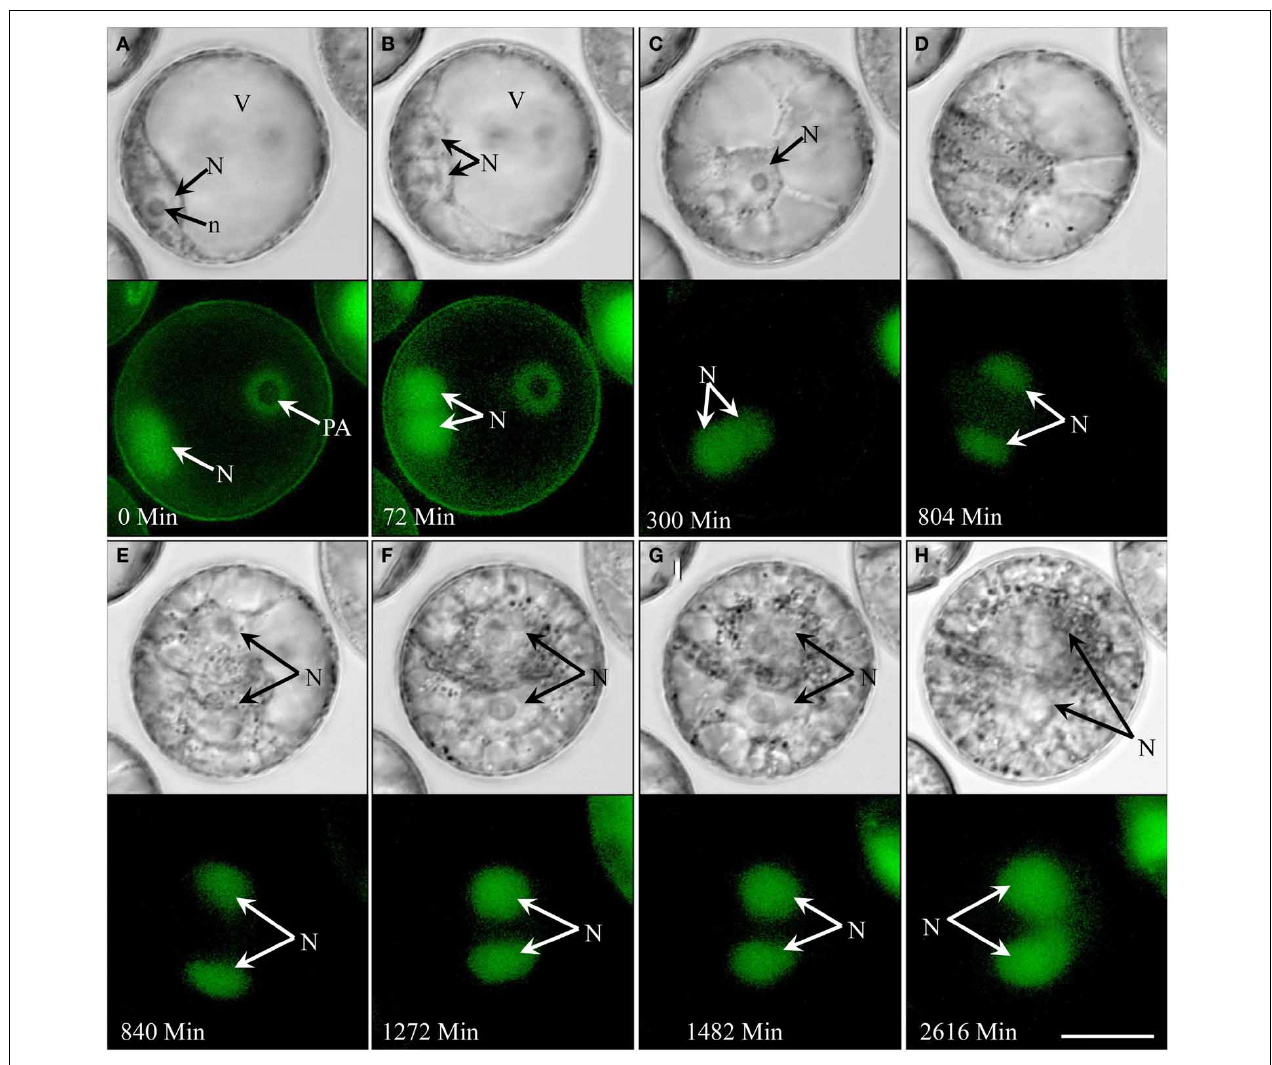
FIGURE 3 | Type III development over time (non-embryogenic pollen) shown by synchronously acquired DIC and fluorescence images. After the initial symmetric division, the pollen remains bi-cellular, showing no further cell divisions but gradually accumulating starch while remaining viable throughout the observation period (14 days). (A) Uni-nucleate pollen with